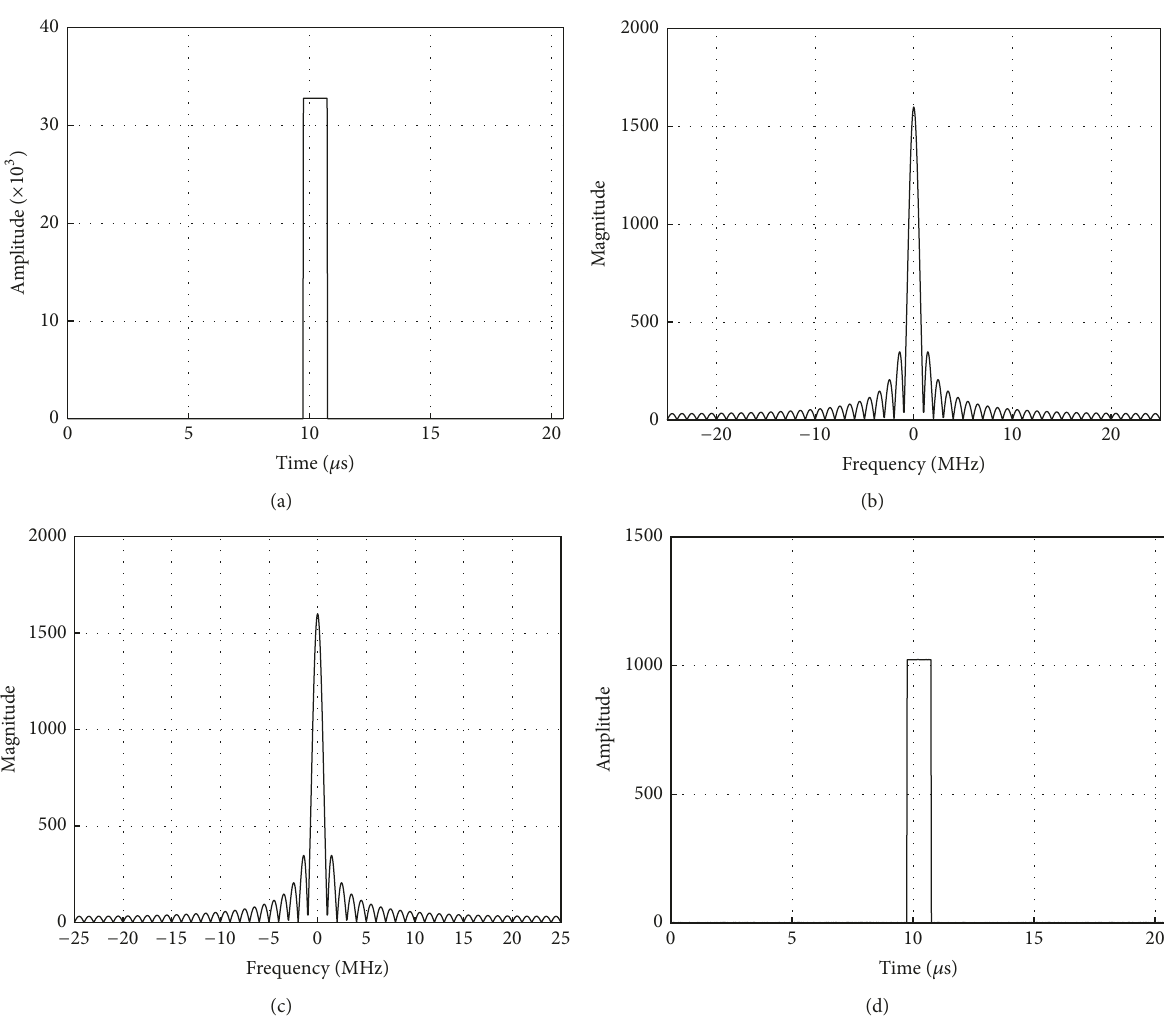
Figure 16: Matlab and FPGA results of a 1024-point FFT and IFFT core tested with rectangular pulse input waveform. (a) Rectangular pulse waveform, (b) 1024-point FFT core output using Matlab, (c) 1024-point FFT core output using FPGA, and (d) 1024-point IFFT core output using